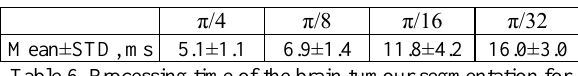
Figure 15. Processing time of the brain tumour segmentation (in milliseconds) of the proposed algorithm for different ∆φ